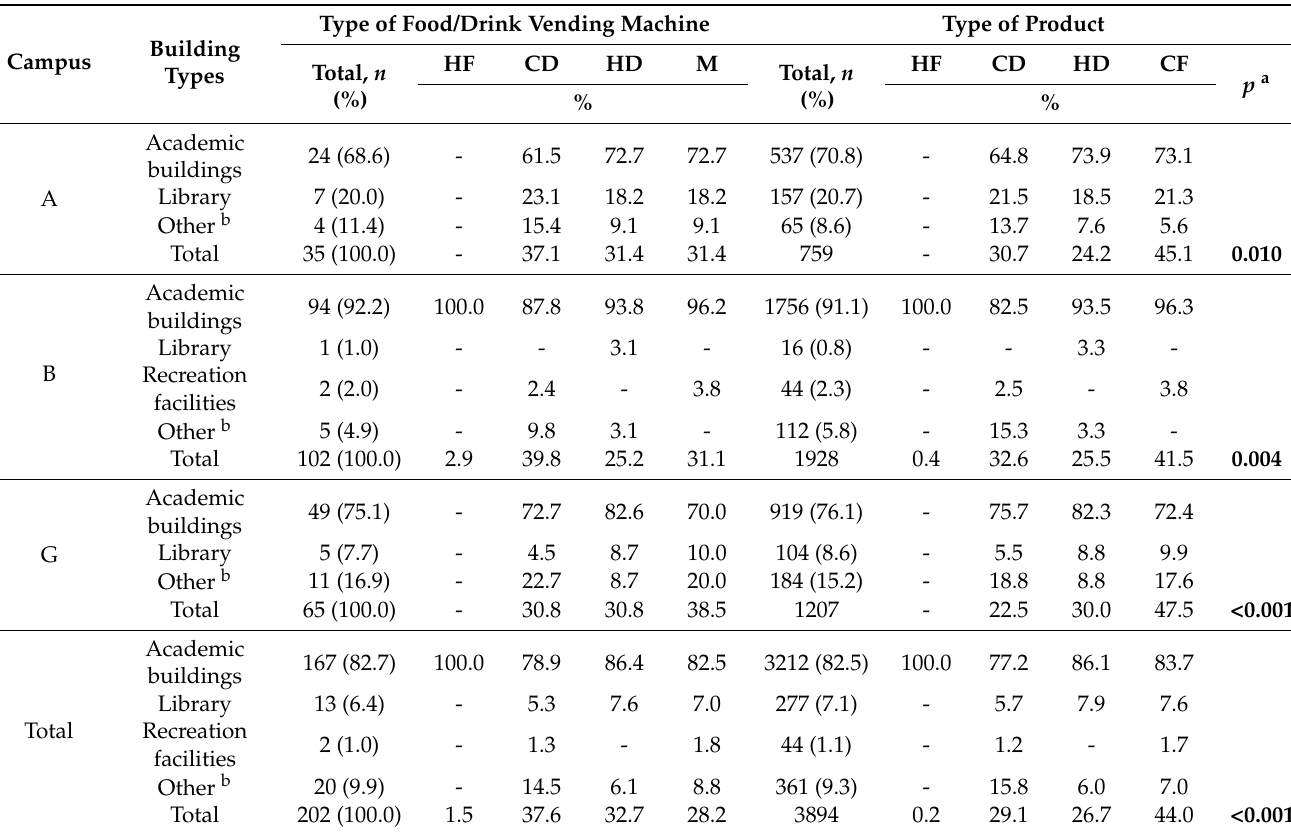
Table 2. Types of vending machines and products sold at the University of the Basque Country (Spain) by campus.